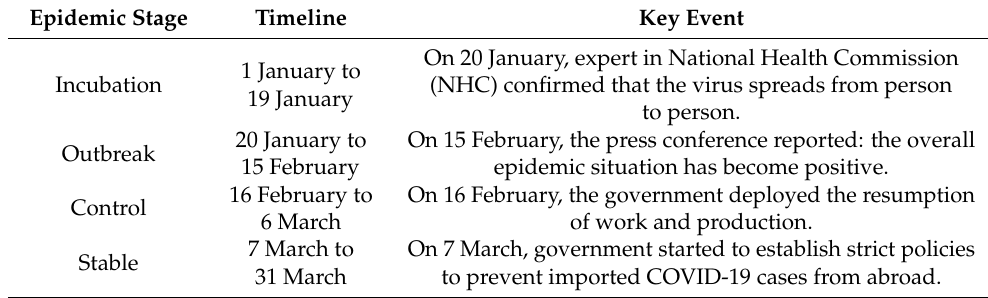
Table 1. Key events and stage division of early COVID-19 in China.